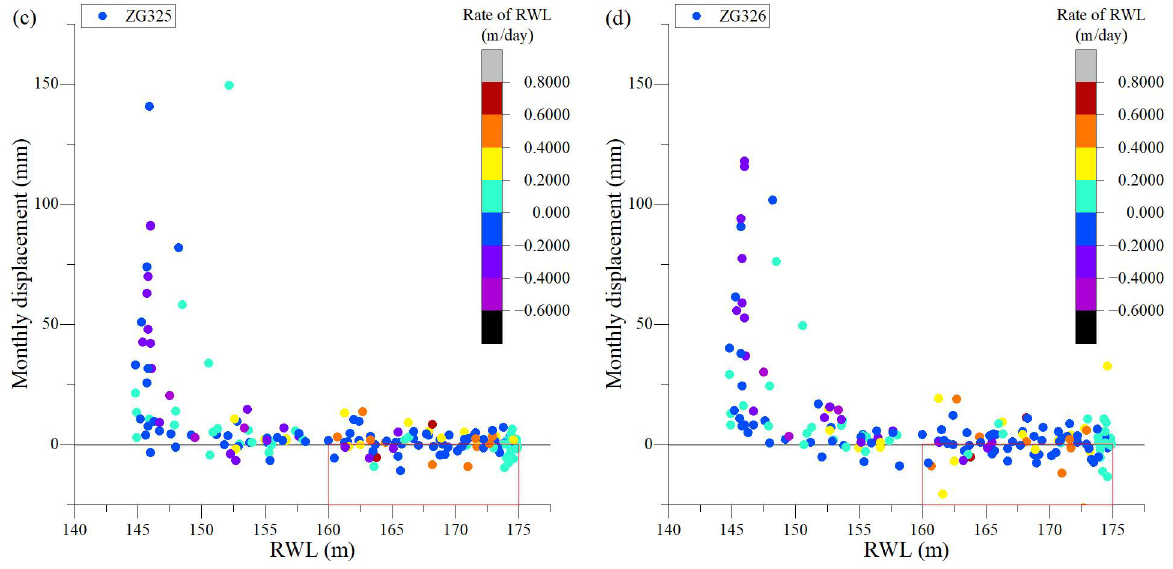
Figure 16. Effects of RWL on landslide displacement. ( a ) ZG323; ( b ) ZG324; ( c ) ZG325; ( d ) ZG326.